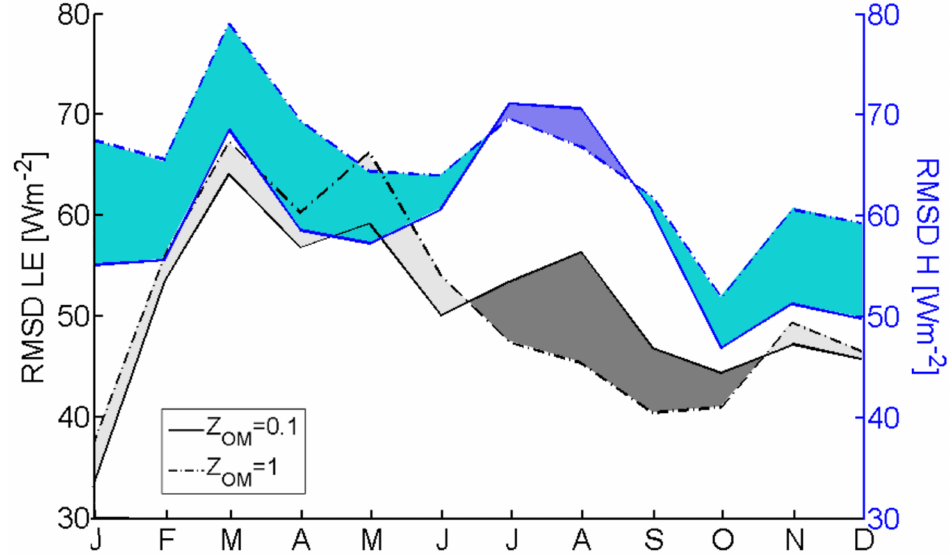
Figure 4. Sensible and latent heat flux RMSD (W m − 2 ) at Las Majadas, obtained for a range of roughness lengths during the year. Blue lines are for the sensible heat flux RMSD. Grey lines for the latent heat flux